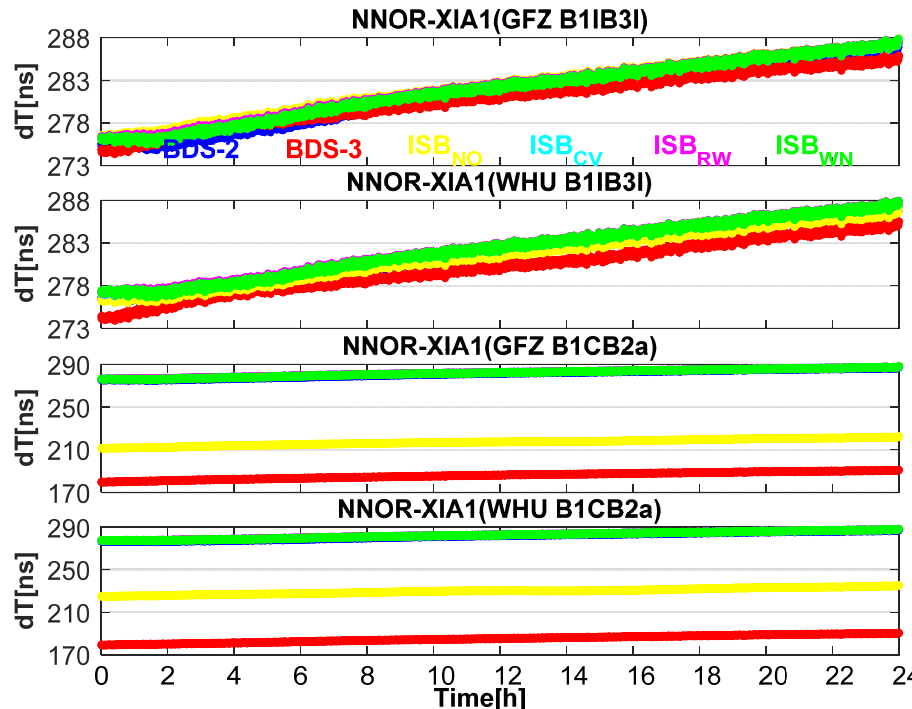
Figure 13. The clock differences of BDS-2-only, BDS-3-only, and BDS (BDS-2/BDS-3 using the four ISB stochastic models) based on the time-link NNOR-XIA1 on DOY 114, 2020.